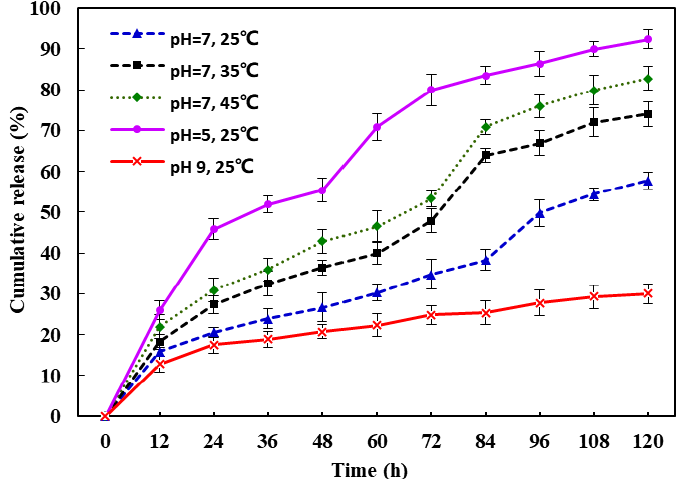
Figure 3. Effect of pH value and temperature on the release behaviors of imazalil from imazalil IL- 3@HKUST-1. IL-3@HKUST-1.